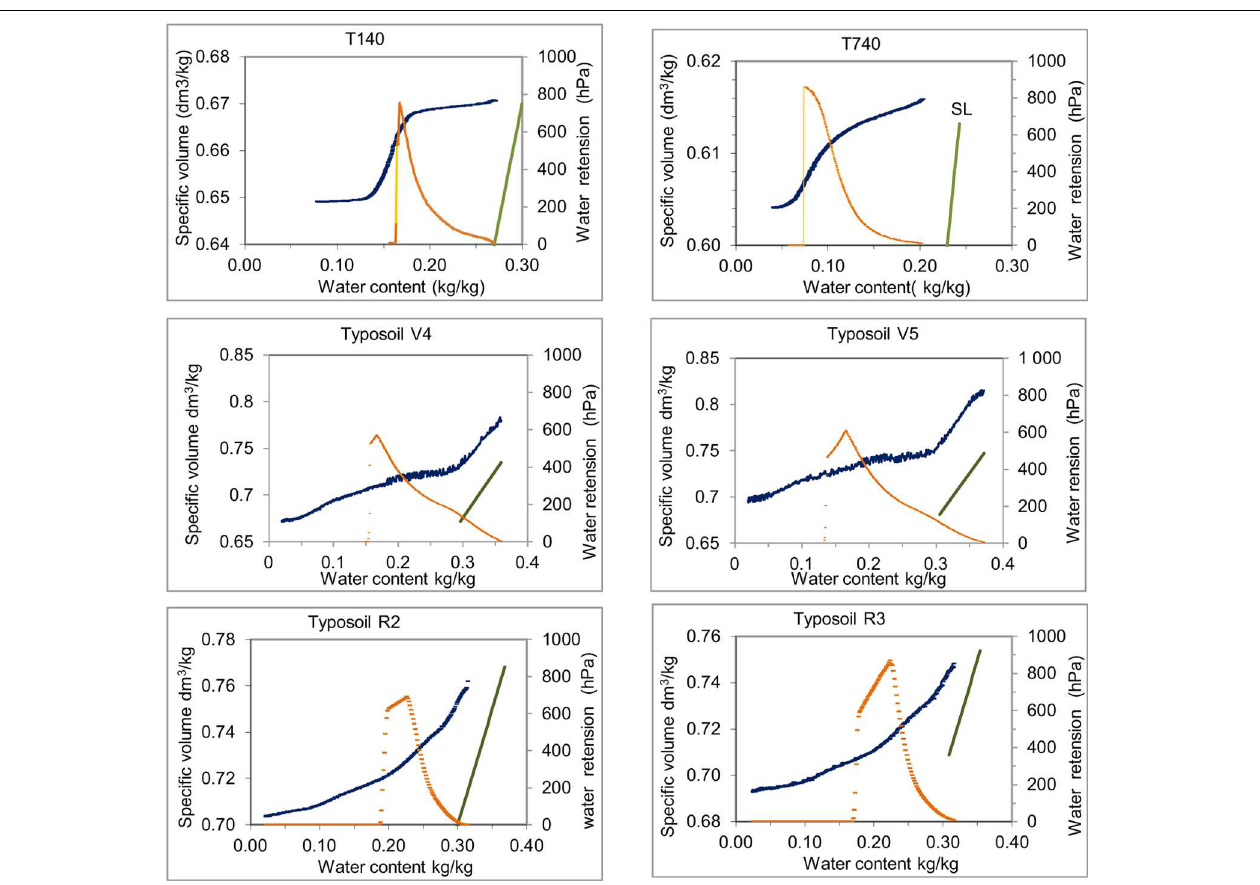
FIGURE 7 | The measured soil shrinkage (blue) and water retention (orange) curves of the soil samples used as examples in this study. The two first samples T140 and T740 were measured in Braudeau and Mohtar (2004) using the device on Figure 4 , the others were measured in this study using